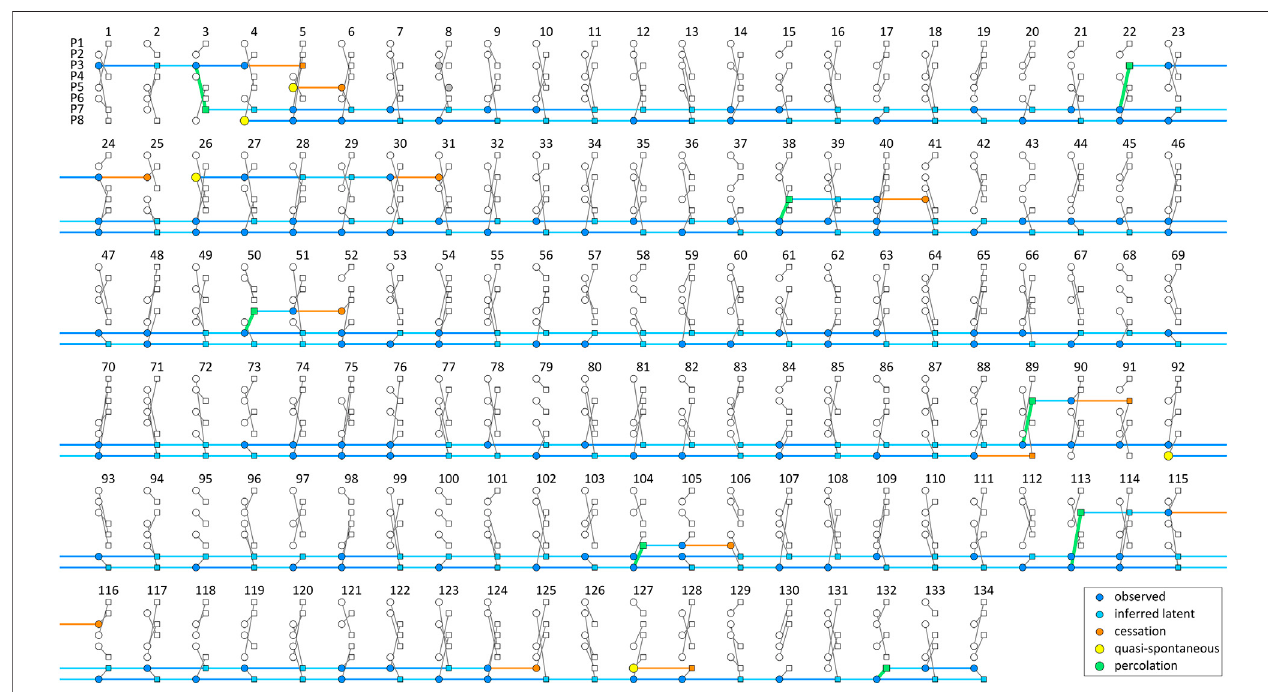
FIGURE12| BehavioralstatetransitionanalysisforVERTICAL → ANDtransition.Roundsincreasefromlefttorightandthentoptobottom.Giverandrecieverstates areindicatedbycirclesandsquaresrespectively.Giver-receiverpairingsareindicatedbyconnectionswithinrounds.Un fi lledcirclesrepresenttheabsenseoftheuseofa VERTICAL → AND transition (either overt or inferred). Dark blue: overt evidence for target state by giver;light blue: inferred latent state; orange: cessation of state; yellow: quasi-spontaneous emergence; green: possible percolation of state.